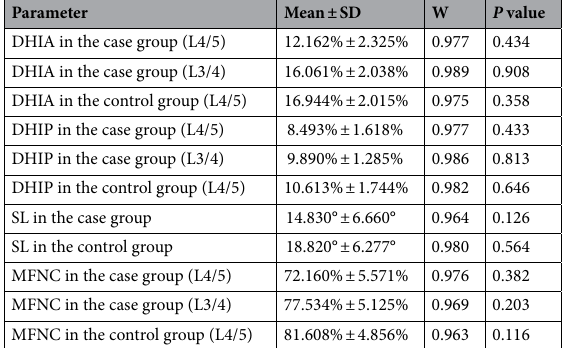
Table 3. The average values of each parameter and normality test. W: Indicator to judge the normal distribution. When W is close to 1 and P is more significant than 0.05, the data can be considered to obey the normal distribution.